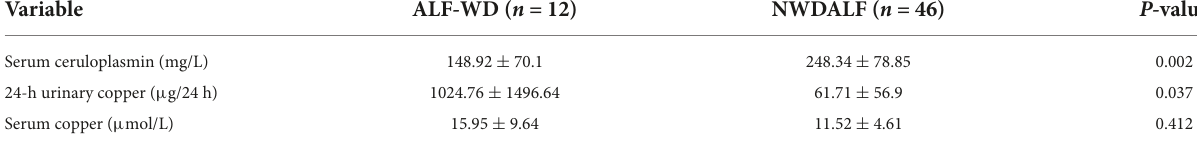
TABLE 3 Comparison of copper metabolism parameters of children with ALF-WD or NWDALF.